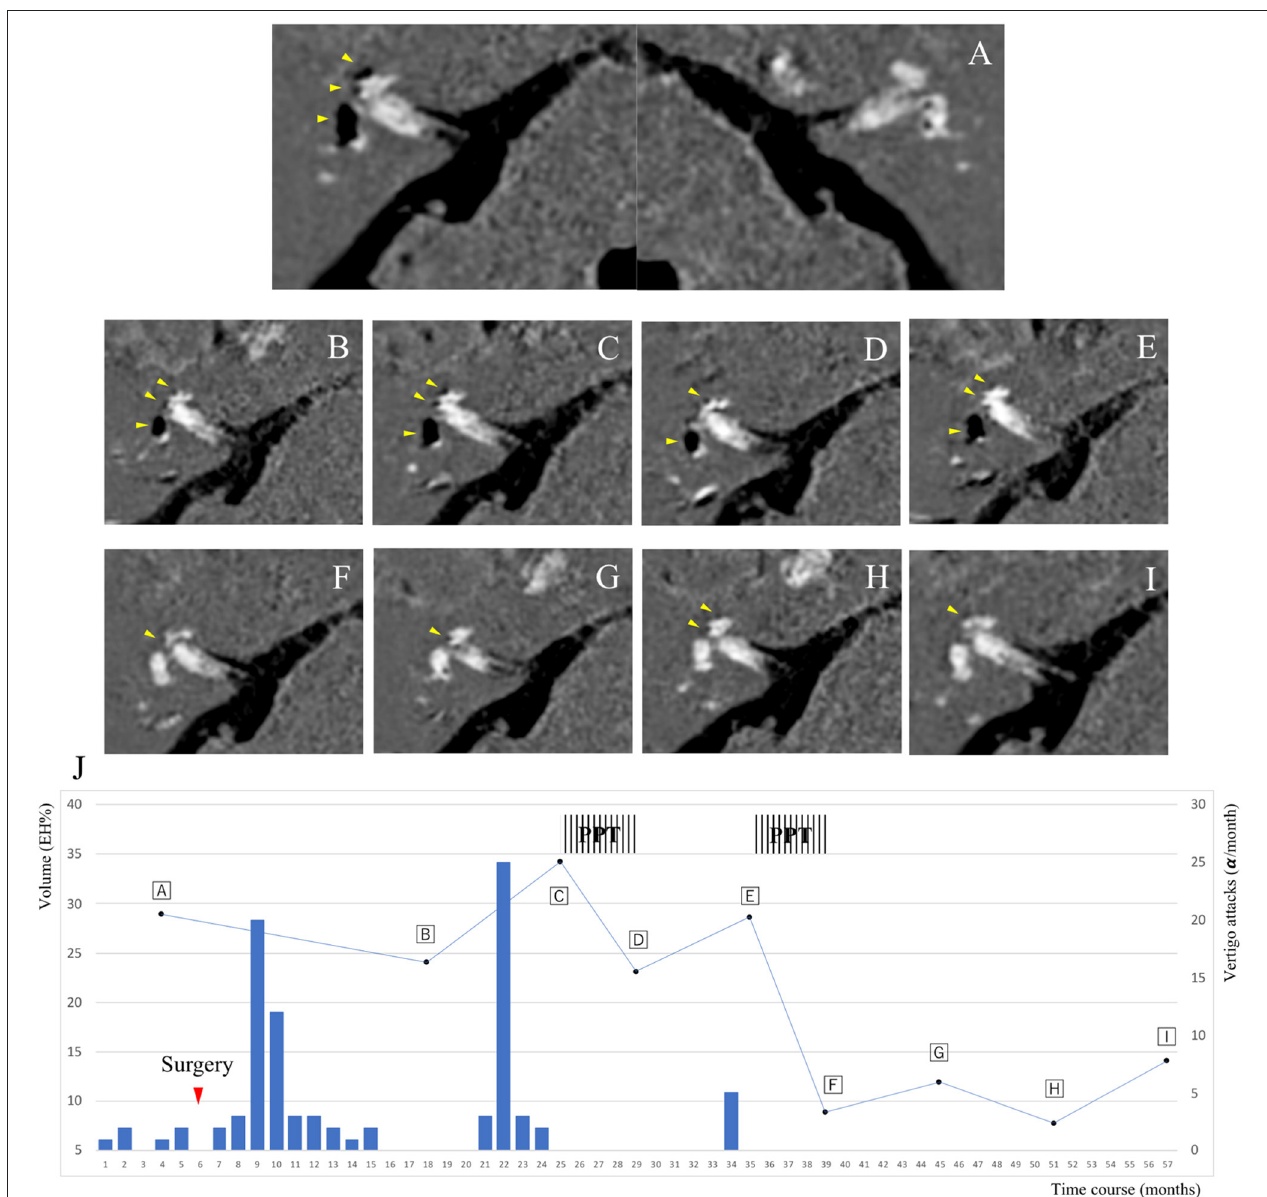
FIGURE 1 | Course of endolymphatic hydrops (EH) and progression of vertigo attacks in a 68-year-old man. The patient’s course was semi-quantitatively assessed by gadolinium-enhanced inner ear magnetic resonance images, which are shown in (A–I) (axial T2-weighted fluid-attenuated inversion recovery). The y axis on the left indicates the volume ratio of EH to the total inner ear volume in the right ear. (J) is a progress chart of the patient’s vertigo attacks as frequency per month on the y axis (right-hand side). (A) Significant EH in the right vestibule and cochlea. No EH in the left vestibule and cochlea. May 2015. (B) Mild EH in the right vestibule and cochlea. July 2016. (C) Significant EH in the right vestibule and mild EH in the right cochlea. February 2017. (D) Mild EH in the right vestibule and cochlea. June 2017. (E) Significant EH in the right vestibule and mild EH in the right cochlea. December 2017. (F) No EH in the right vestibule and mild EH in the right cochlea. April 2018. (G) October 2018. (H) April 2019. (I) November 2019. No EH in the right vestibule and mild EH in the right cochlea. The yellow arrowheads indicate EH, and the black areas represent EH in the labyrinth. (J) The red inverted triangle in the chart indicates the day of surgery. The vertical stripes indicate the durations of the positive pressure